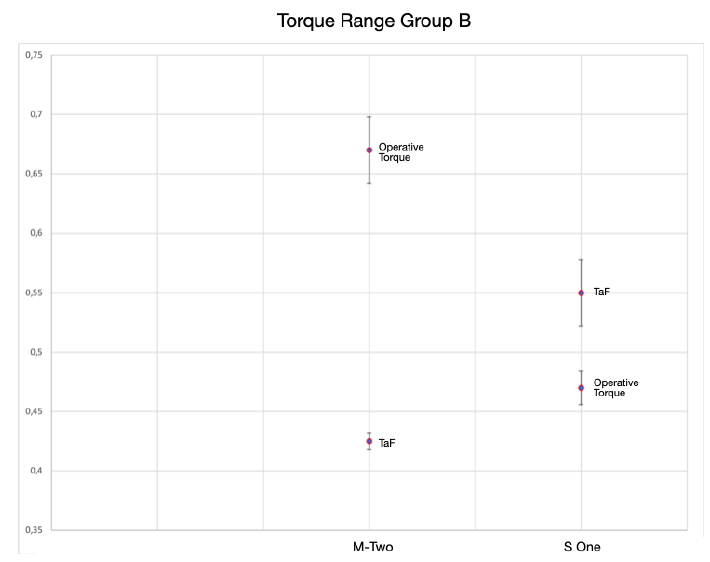
Figure 3. Torque range evaluation for M-Two 20.06 and S-One 20.06.